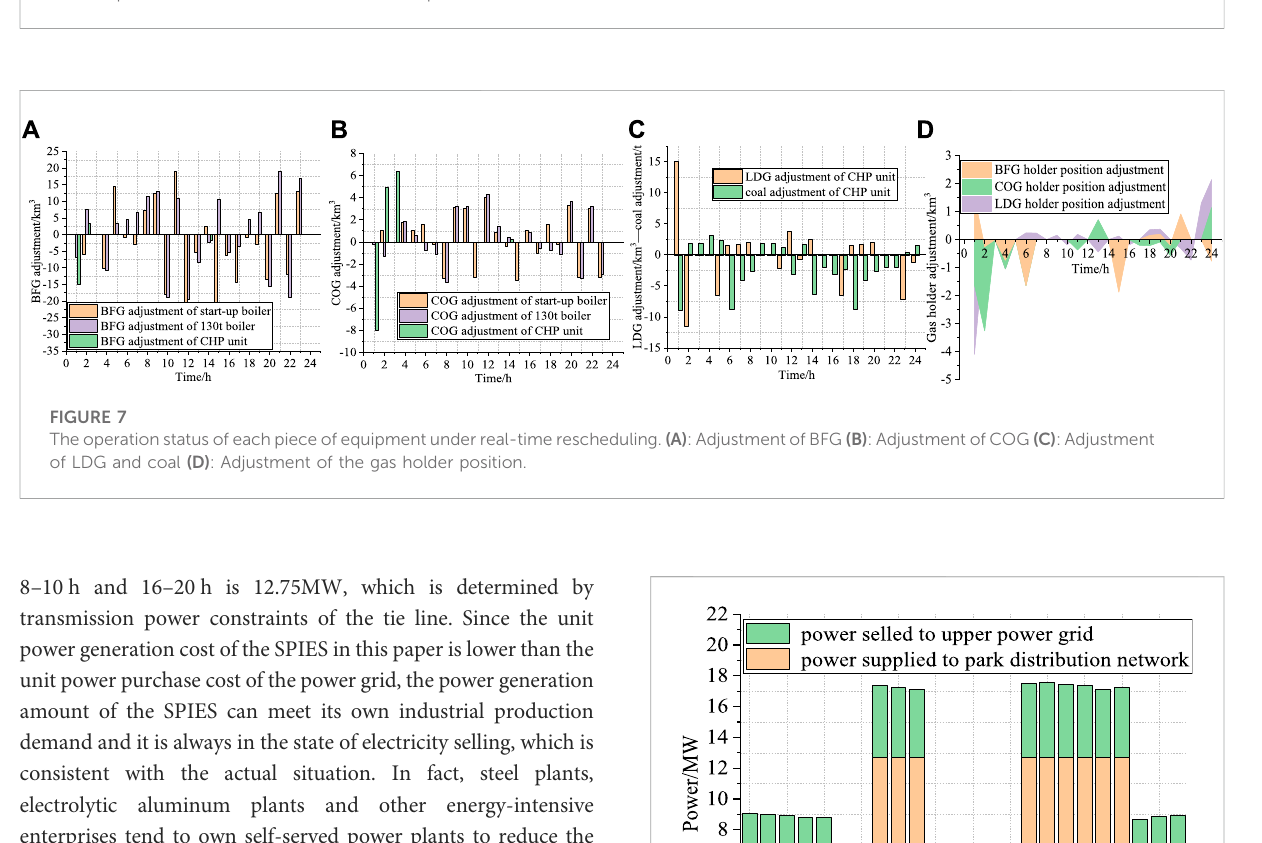
FIGURE 6 The operation status of each piece of equipment under day-ahead scheduling. (A) : Consumption of BFG (B) : Consumption of COG (C) : Consumption of LDG and coal (D) : Gas holder position.